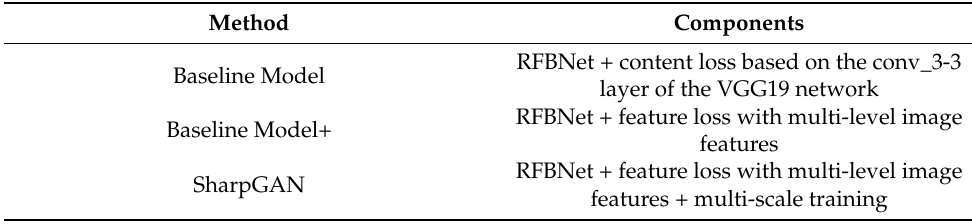
Table 1. Components of each